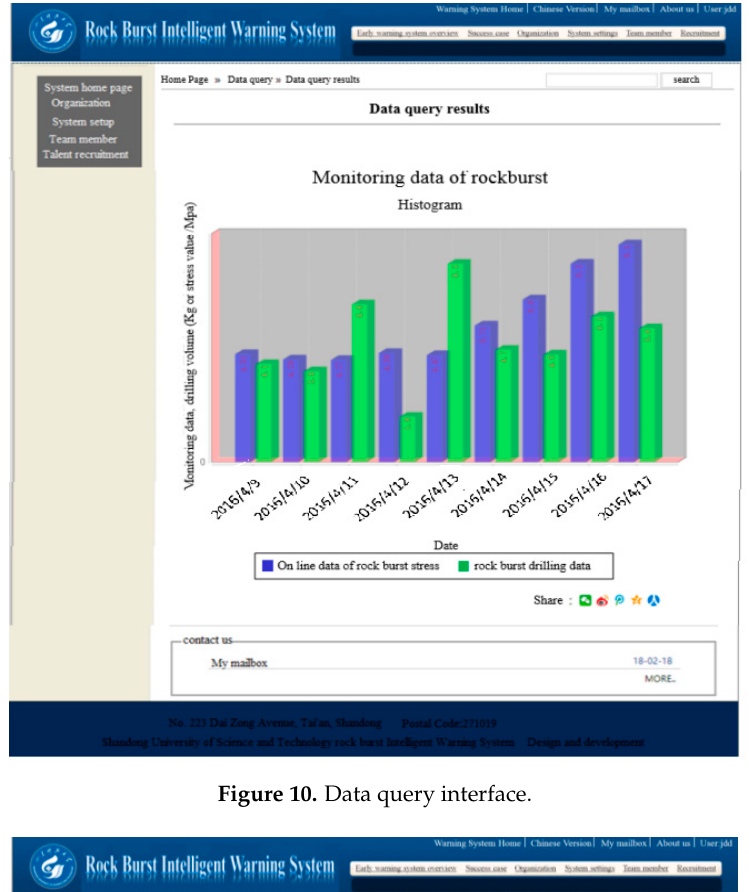
Figure 10. Data query interface. Processes 2019 , 7 , x FOR PEER REVIEW